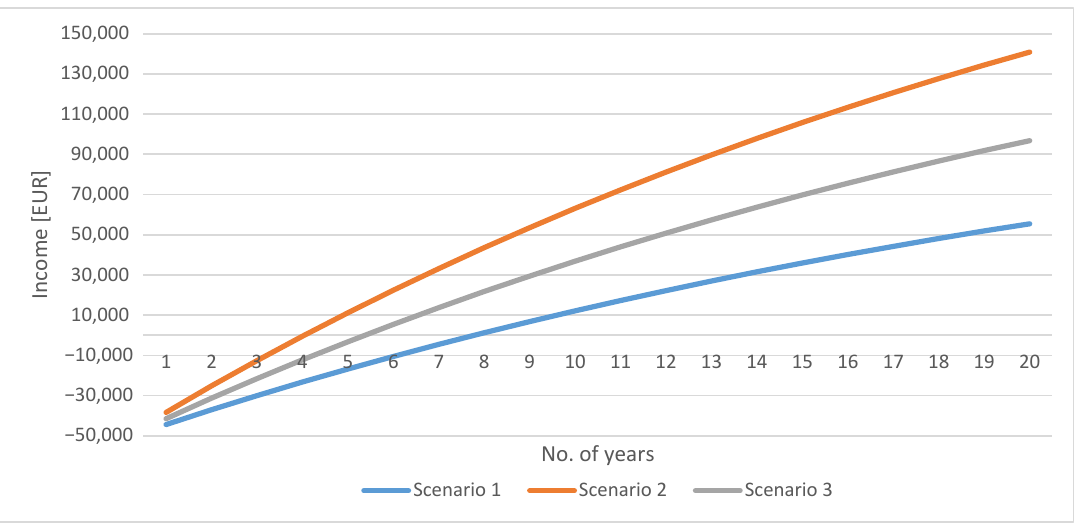
Figure 2. Payback period evolution for all scenarios.